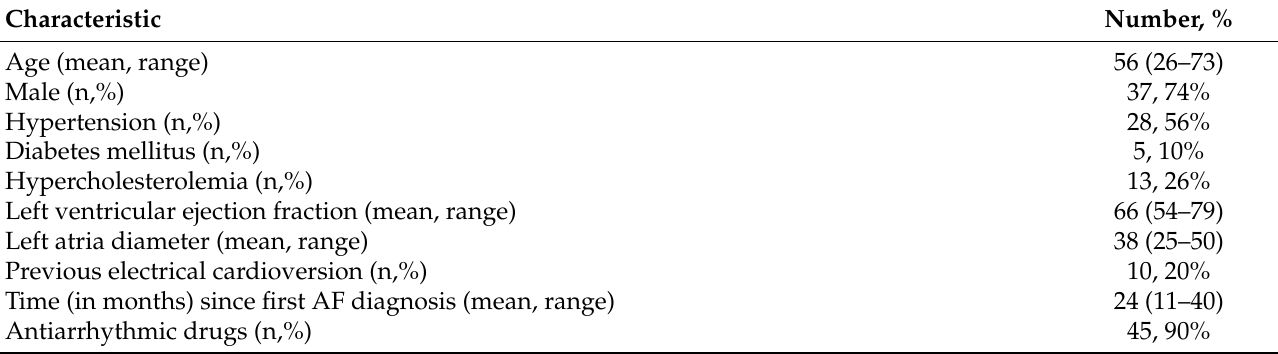
Table 1. Baseline characteristics of study population. Hypertension defined as systolic blood pressure above 140 mmHg or diastolic blood pressure above 90 mmHg. Diabetes mellitus defined as serum fasting glucose ≥ 7.0 mmol/L or on medications. Hypercholesterolemia defined as cholesterol ≥ 6.4 mmol/L or treatment with lipid-lowering drugs. Structural heart disease defined as left ventricular hypertrophy < 15 mm, left ventricular ejection fraction (LVEF) < 50%, moderate or greater degrees of valvulopathy, significant coronary artery disease, or the presence of primary myocardial diseases. Detailed information about antiarrhythmic drugs is also